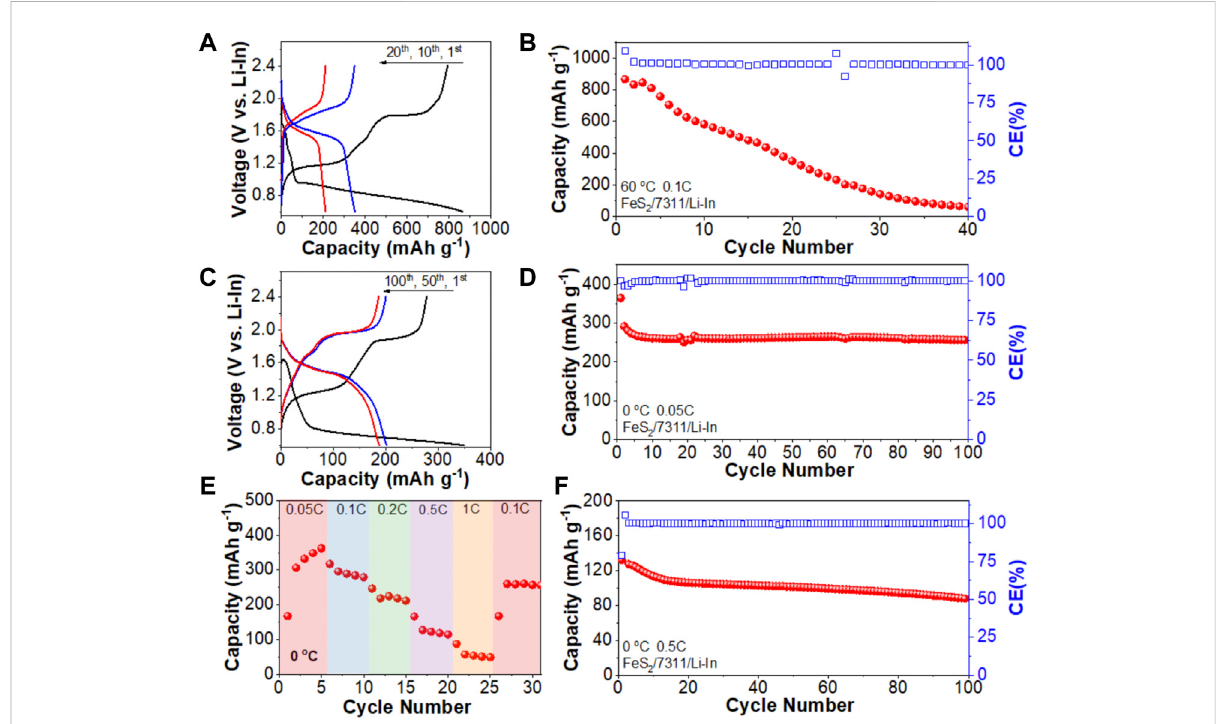
FIGURE 5 (A) The 1st, 10th, and 20th charge/discharge curves and (B) the cycling performances of the FeS 0.6and2.4 V(vs.Li-In)under60 ° C. (C) The1st,50th,and100thcharge/dischargeplotsand (D) thecyclingperformancesoftheabovebatterycycled at0.05 ° Cinthesamevoltagewindowunder0 ° C. (E) Theratecapabilitytestoftheabovebatterymeasuredat0 ° C. (F) Thecyclingperformancesofthe